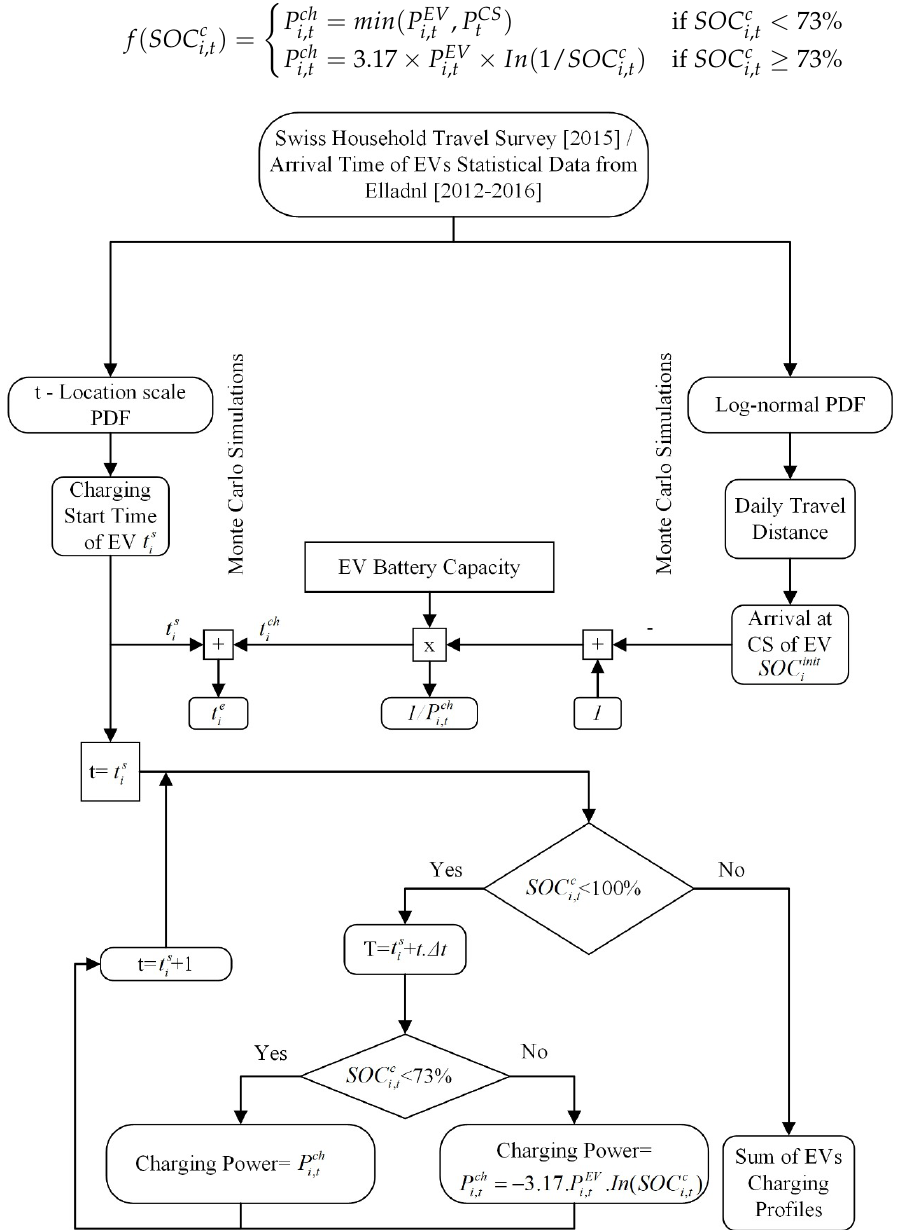
Figure 3. SOC-based dynamic charging coordination